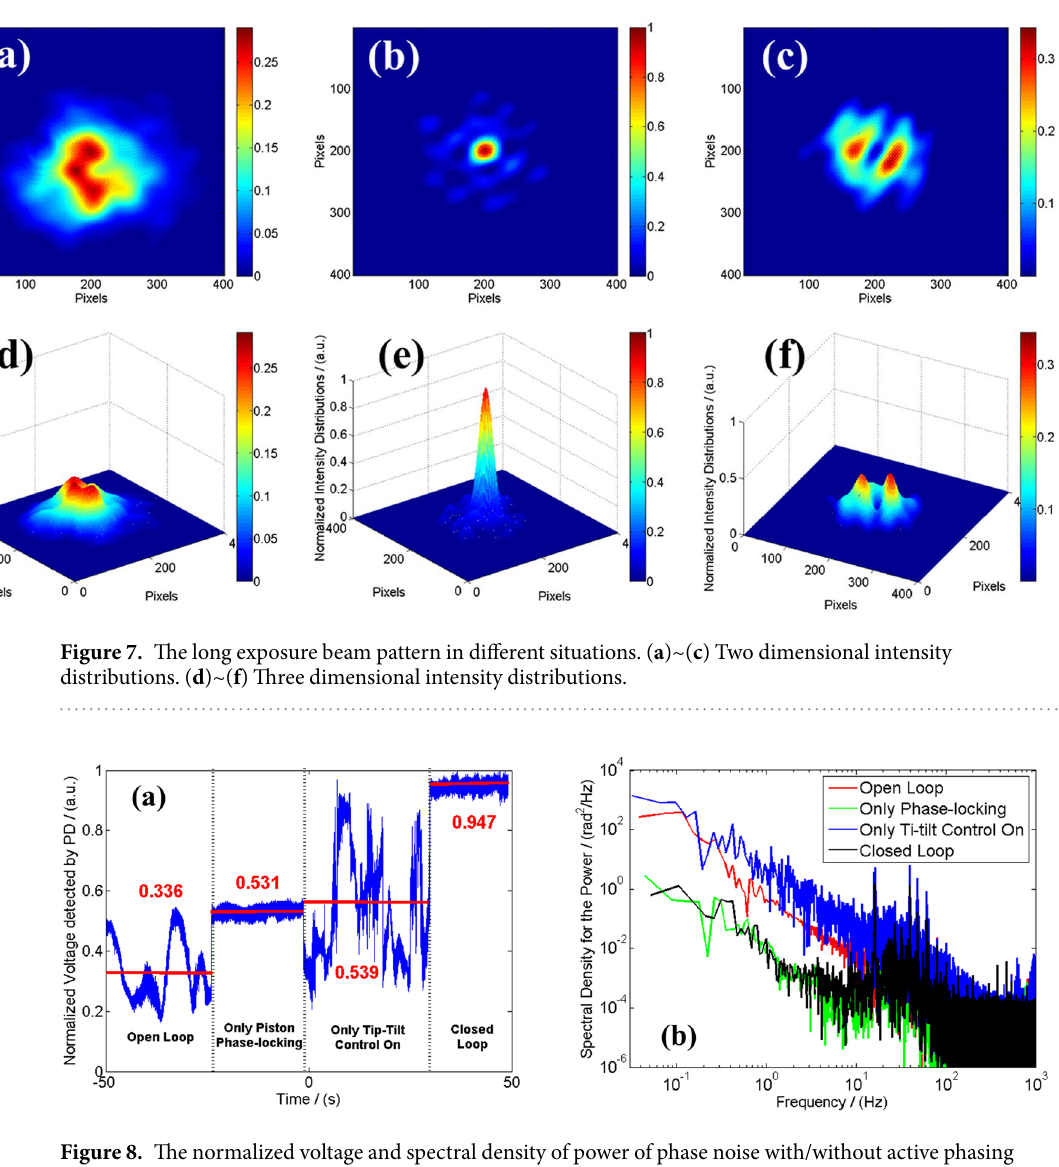
compensation and to validate the performance of the AFOC array, we introduce small tip-tilt phase aberrations over each of the seven beams and start over both of the piston and tip-tilt phase control systems. The normalized voltage recorded by the PD as the function of time in different situations is shown in Fig. 8(a). The metric function in open loop (without tip/tilt control and phase-locking control) fluctuates within a small range with mean value of 0.336. When the phase-locking control is performing, the time-dependence signal has remained stable with a higher average value of 0.531. After that we start the tip/tilt control and close the phase-locking control, the detected signal with the normalized average value of 0.539 fluctuates heavily along with time, which represents the amplification of phase differences turbulence among the seven laser chains. In closed loop (both of the phase-locking control and the tip/tilt control are performing), the average of the nor- malized PIRB increases to 0.947 and the RMS decreases to 0.012 with the residual phase errors lower than λ /28, which means that the two controls have been achieved successfully and the homemade AFOC array works well. Figure 8(b) shows the spectral density of power of phase noise in different situations corresponding to Fig. 8(a). From Fig. 8(b), we can conclude that the tip-tilt control can improve the spectral density of phase noise, while phase-locking control can suppress the spectral density. To directly observe the feasibility of the two controls, we derive the long exposure (30 seconds) far-field com- bining beam pattern for different stages as shown in Fig. 9 corresponding to Fig. 8(a). Figure 9(a)/(e) and (b)/ (f) present the far-field beam patterns without and with the phase-locking control, respectively, but both without tip-tilt control. As depicted in Fig. 9(a) and (b), the combined beam distributes in a large area in the far-field, even though the fringe contrast increases from 19% to 66% due to the phase-locking control. As the tip-tilt errors are